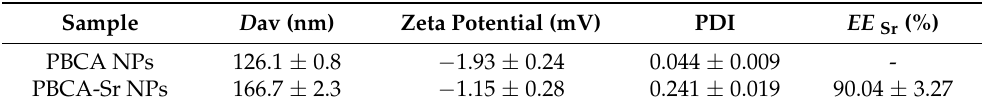
Table 1. The average diameter (Dav), zeta potential, polydispersity (PDI), and entrapment efficiency of strontium of